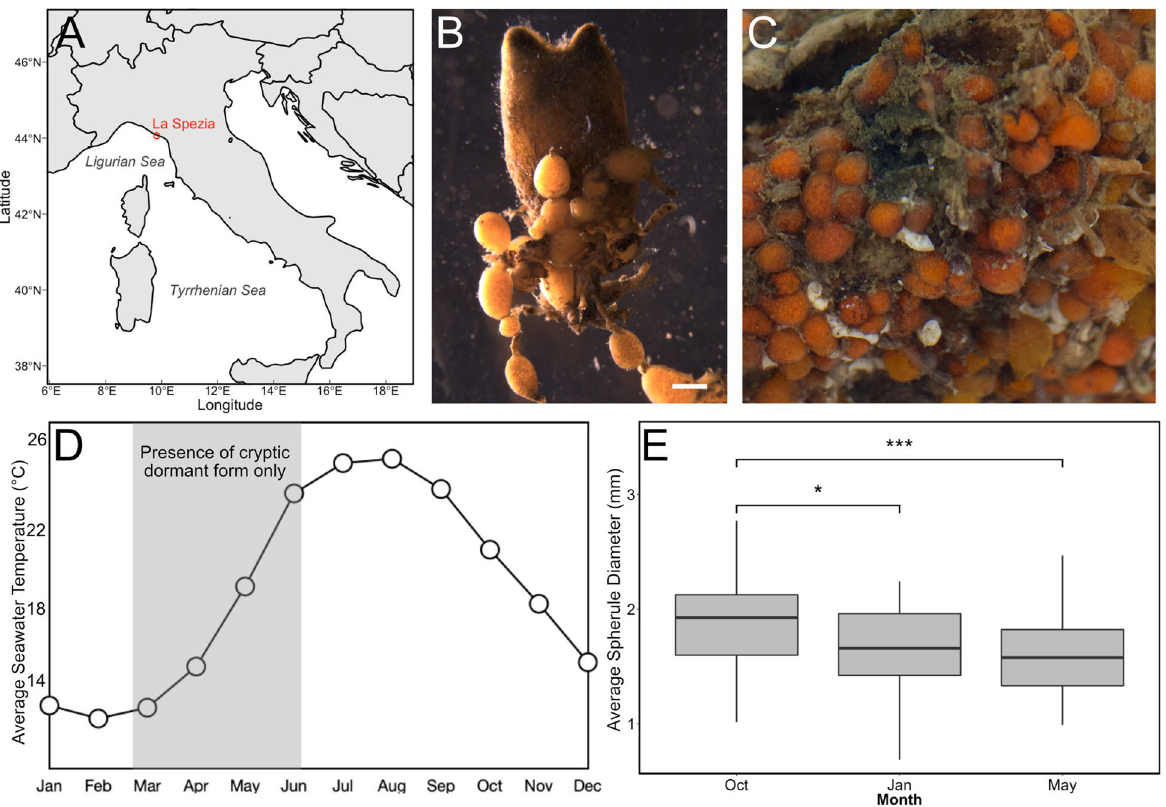
Figure 5. Field colony dynamics of Polyandrocarpa zorritensis in La Spezia, Italy. ( A ) Map shows collecting location in La Spezia in the NW of Italy. ( B ) Zooid collected from the harbor of La Spezia, with spherules attached along stolonal projections. Scale bar is 2 mm. ( C ) Close-up of dormant spherules. ( D ) Average surface seawater temperature in La Spezia (NOAA Sea Surface Temperature satellite data from AVHRR Pathfinder SST). Shaded area indicates the period that animals exist in the cryptic dormant form. The rest of the year, both zooids and spherules are found on the ropes in the harbor. ( E ) Graph showing the change in average spherule size (n = 45) over the year, with the largest spherules found in October, and the smallest spherules in